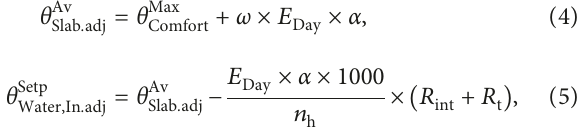
Figure 12: CAV system loads and TABS load with different operation times: (a) 24 hrs; (b) 12hrs; (c) 8